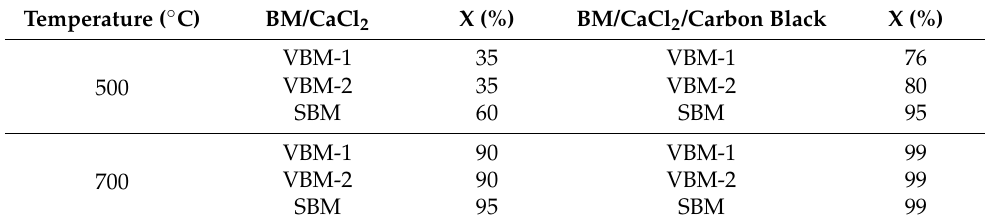
Table 3. Lithium extraction at 500 ◦ C and 700 ◦ C for 60